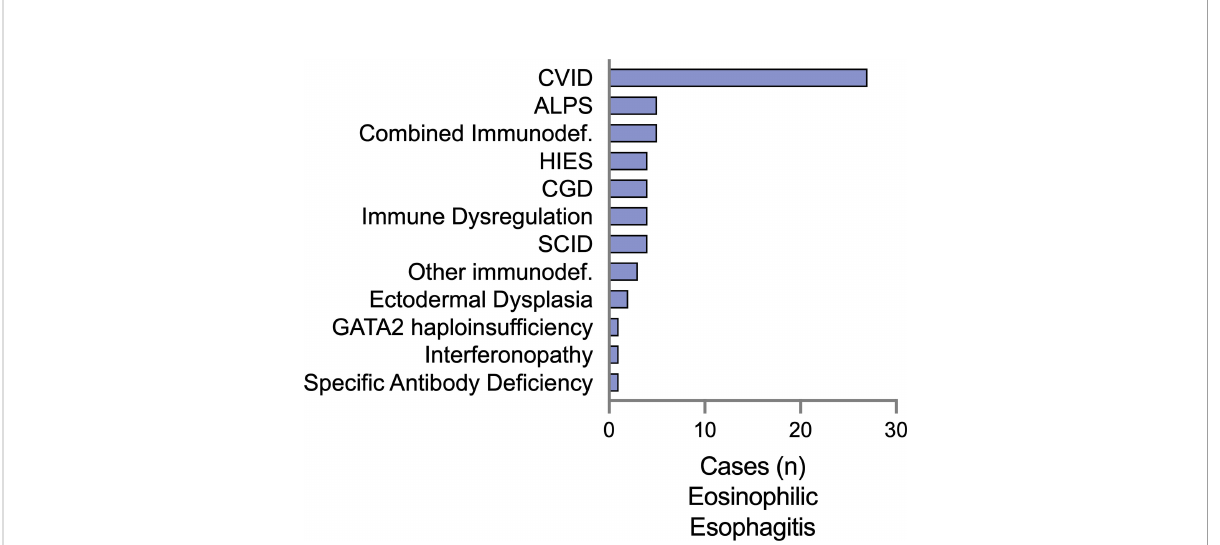
FIGURE 1 Eosinophilic esophagitis (EoE) is a comorbid diagnosis among a diverse set of IEI in the USIDNET. The number of patients with EoE as a listed condition are represented using the immunode fi ciency category as de fi ned by USIDNET at the time of data collection. CVID, Common